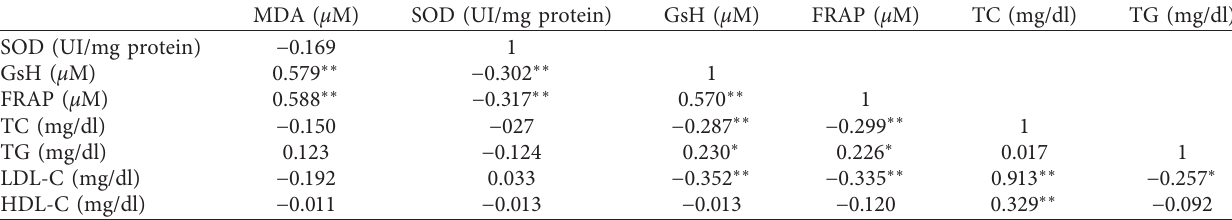
Table 8: Correlation between lipid profile and some markers of